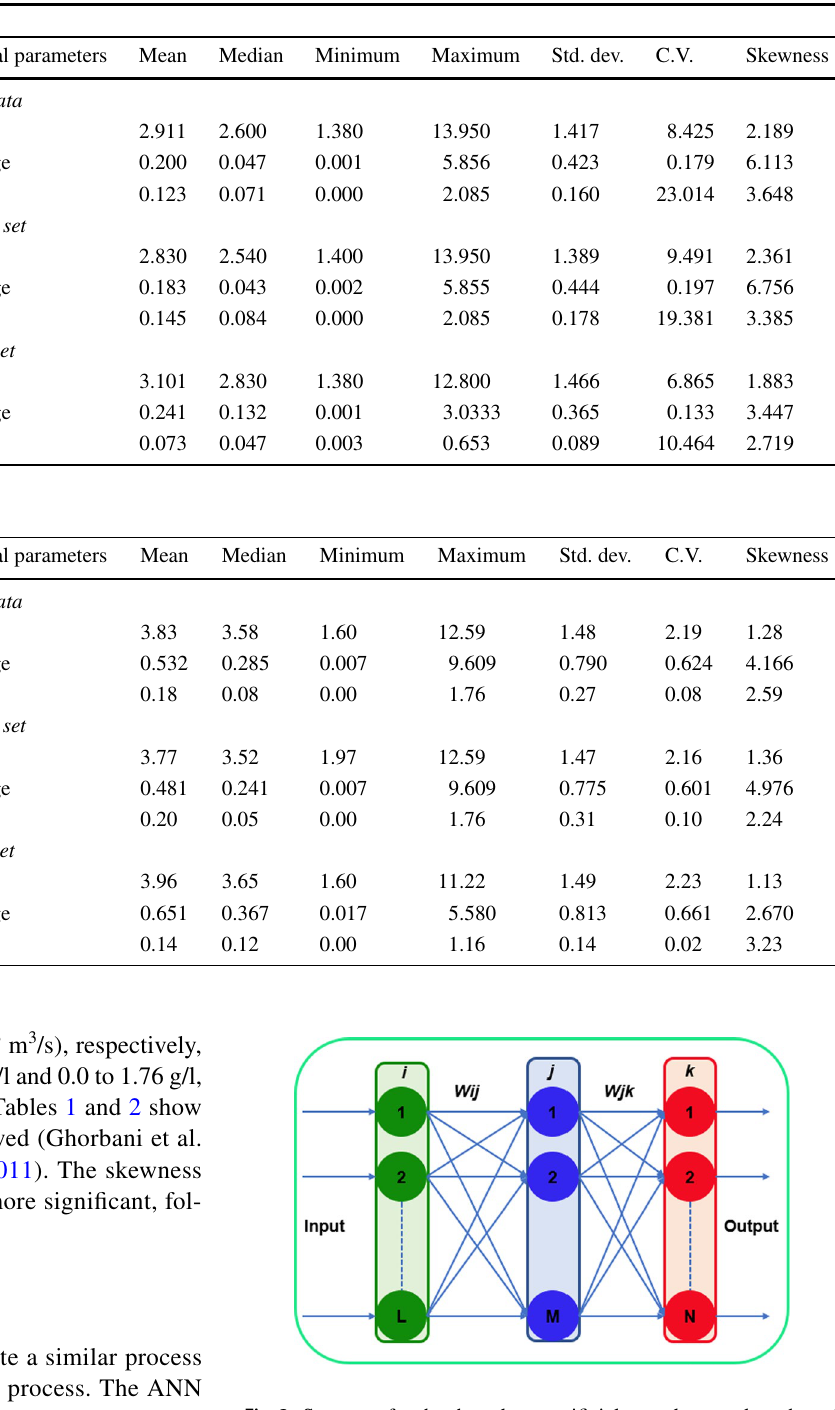
Fig. 3 Structure for the three-layer artificial neural network, adapted from Kişi